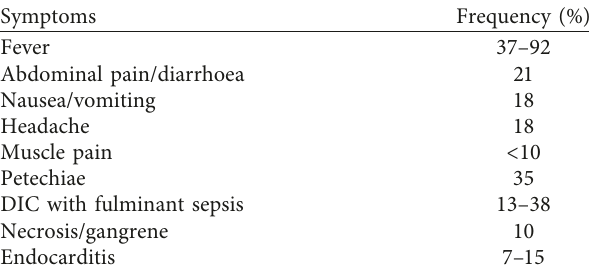
Figure 5: Dilated vessels, disseminated haemorrhage, and oedema of the brain. The brain shows ubiquitously oedema with loosened parenchyma. The vessels are dilated (arrows). Diffuse erythrocyte extravasation is shown (double arrows; haematoxylin and eosin, original magnification 4x insert, original magnification